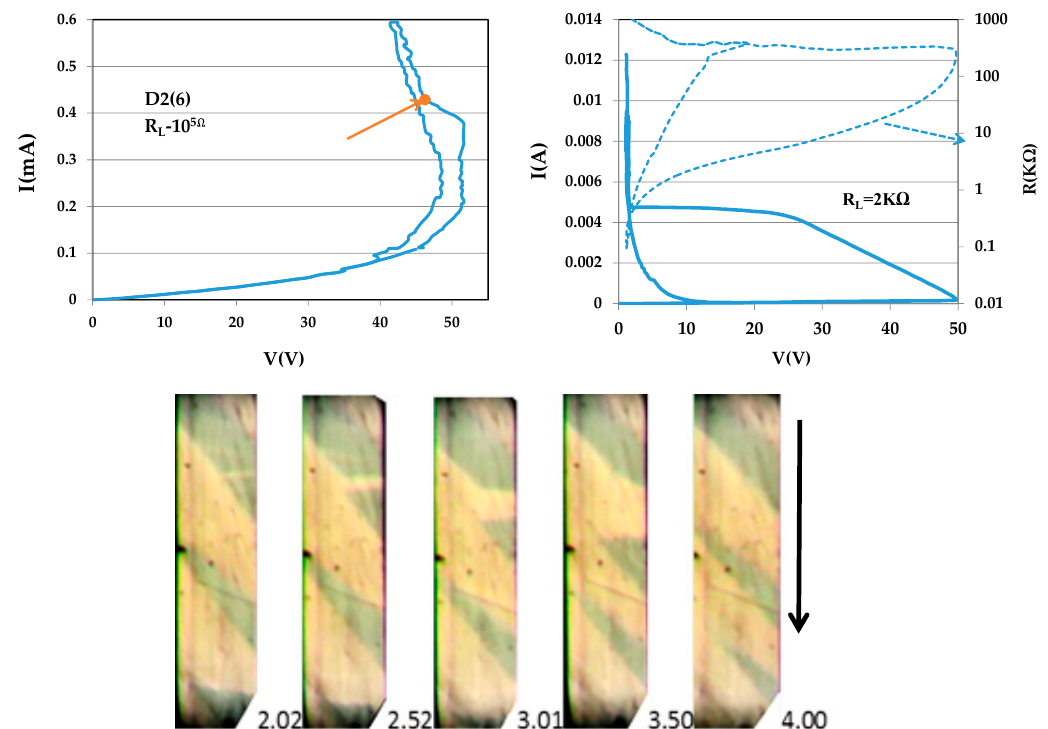
Figure 4. I–V characteristics for sample D2(6) with two load resistances. The images of metal (M, dark)–insulator (I, bright) domains snipped from the video 0.5 s apart at the point on the loop at left marked by the arrow. The pattern changes with time; the width of a barely visible narrow semiconducting domain increases with time, and the domain changes inclination.